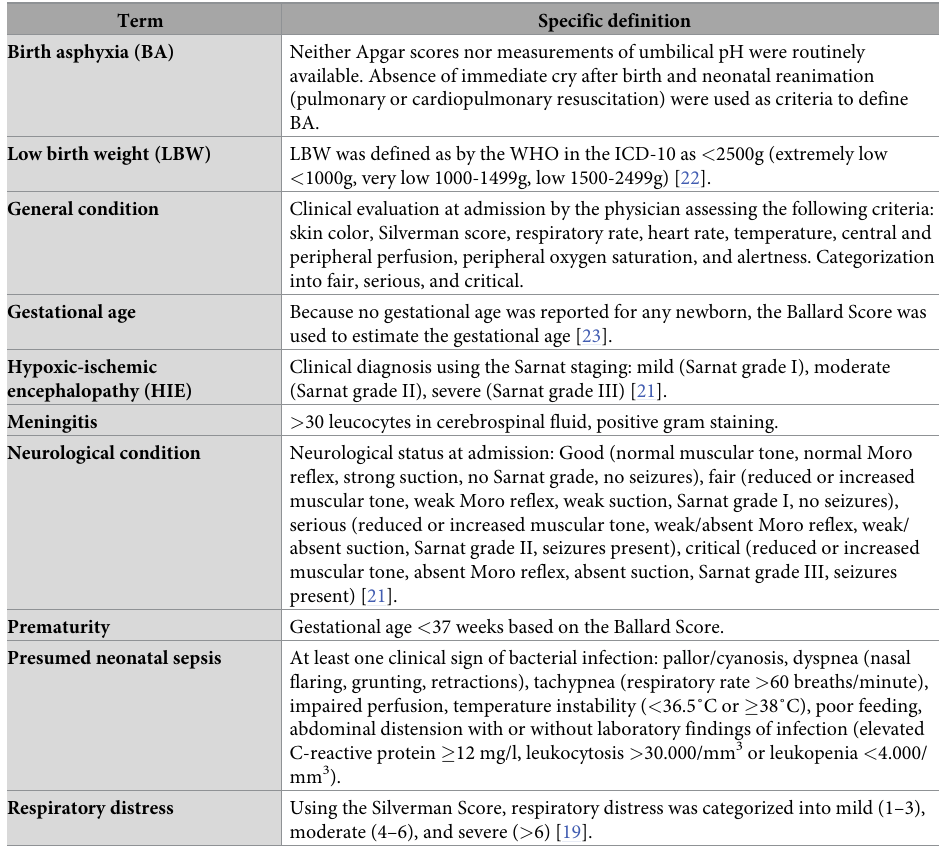
Table 1. Specific definitions of terms used in this